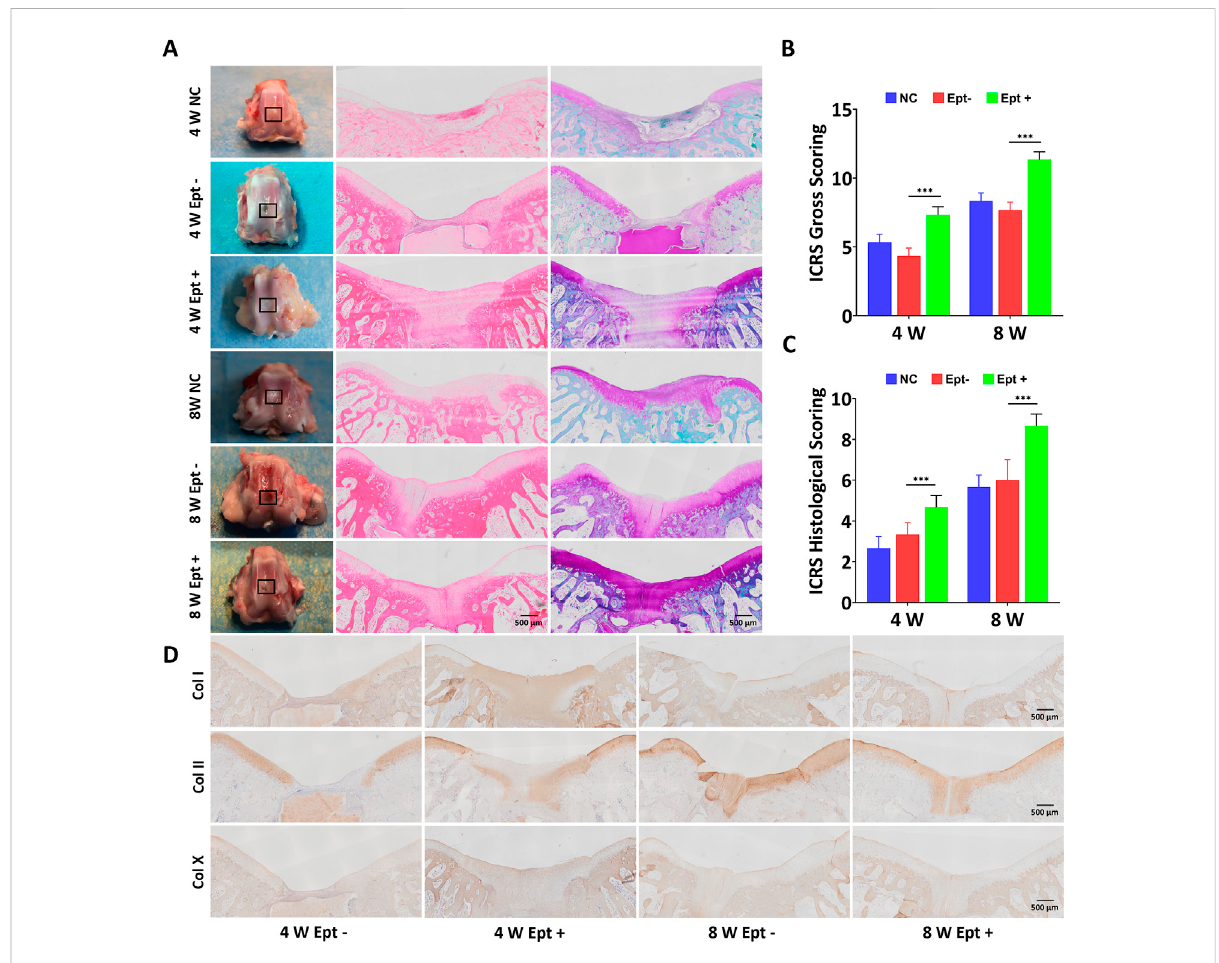
FIGURE 1 Comparison of osteochondral repair in the untreated group (NC), scaffold-only group (Ept – ) and Ept loaded scaffold group (Ept+) at 4 and 8 weeks. (A) Macroscopic analysis, hematoxylin and eosin staining, and safranin O staining of the knee joints. Black rectangle indicates the osteochondraldefects. (B) Macroscopicanalysis forcartilagerepairwiththemodi fi edInternationalCartilageRepairSociety(ICRS)grossgrading( n = 3). (C) ICRS visual scoring based on panel D ( n = 3). (D) The immunohistochemical staining against collagen (Col) types I, II and X of the regenerated tissue at 4 and 8 weeks. Mean ±